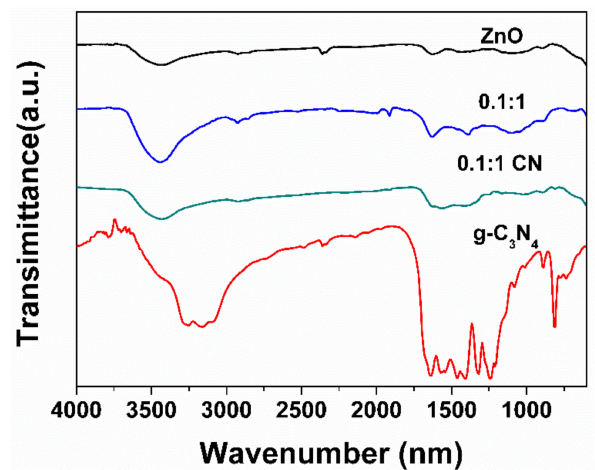
Figure 4. FTIR spectra ZnO, g-C 3 N 4 and g-C 3 N 4 /ZnO nanocomposites synthesized through different